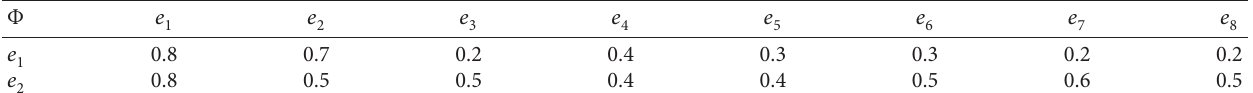
Table 6: Tabular representation of a fuzzy soft vertex set.